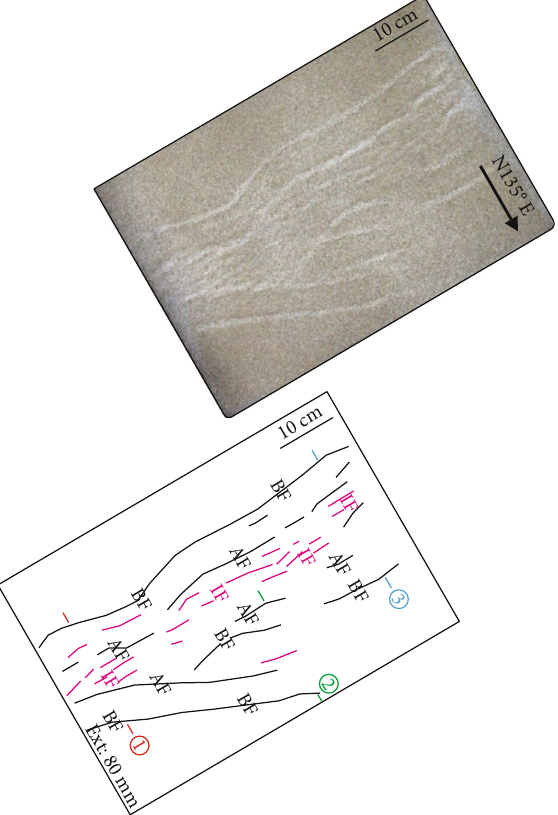
Figure 12: Evolution and characteristics of deformation in model 4, with a di ff erent extension direction. (a) Top-view photo (upper panel) and schematic line-drawing of structures (lower panel), illustrating boundary faults (BF), antithetic faults (AF), and internal faults